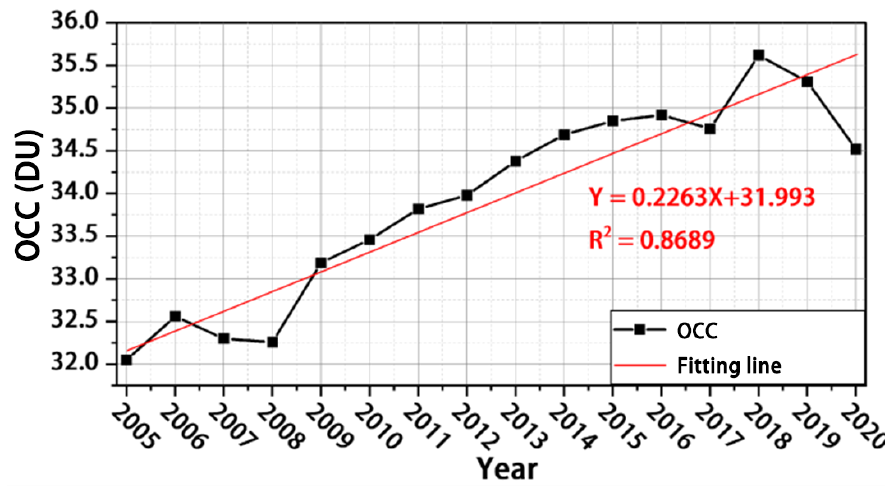
Figure 5. Interannual variation in tropospheric OCC in mainland China.